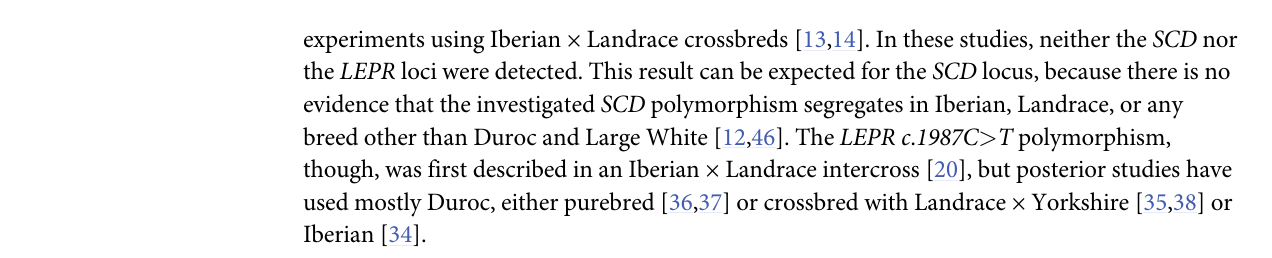
Leptin in plasma, ng/ml